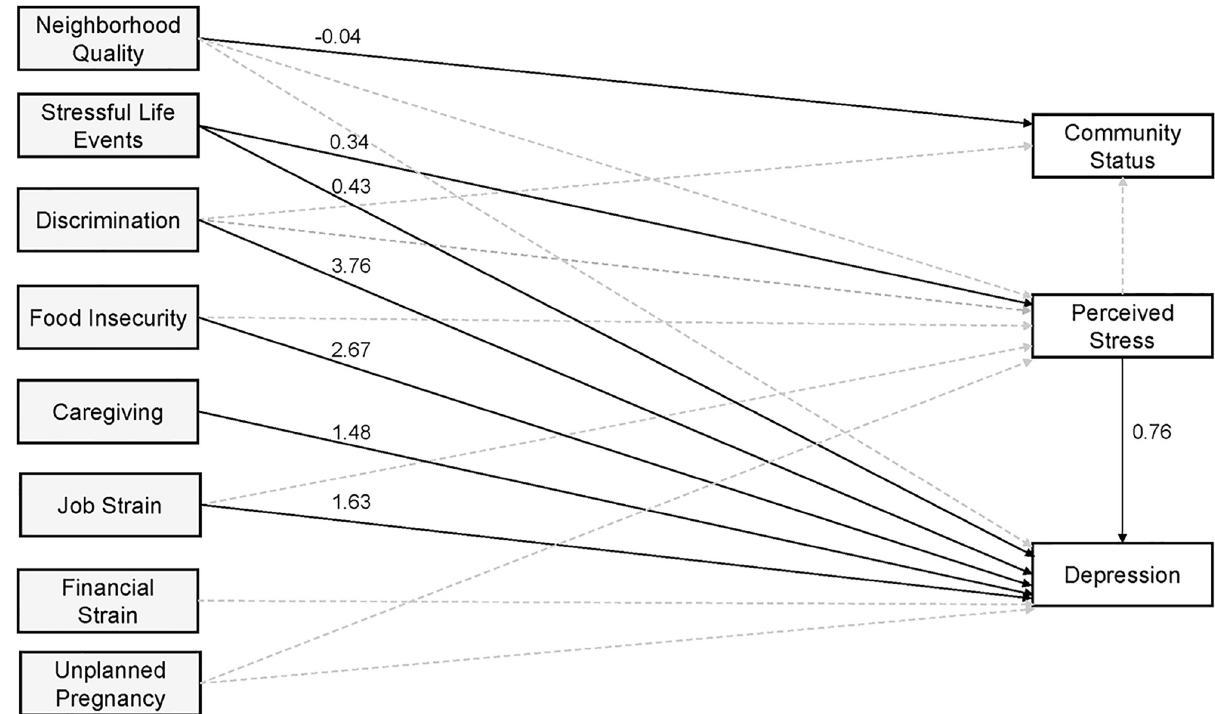
Fig 2. Full empirical model indicating the associations between psychosocial stressors and responses to stress. Overall model had good fit: RMSEA = 0.04, SRMR = 0.01, CFI = 0.99, TLI = 0.96. Model is adjusted for maternal age, maternal education, and maternal race/ethnicity. Solid black lines indicate statistically significant paths at p < 0.05. Gray dashed lines indicate non-significant paths. Effect estimates correspond to path coefficients for the direct effect provided in Table 3. Gray boxes indicate psychosocial stress measures and white boxes indicate responses to psychosocial stress. Higher scores for Perceived Stress, Depression, and Neighborhood Quality indicate higher stressor and response levels. Lower scores for Community Status indicate higher stress response levels.